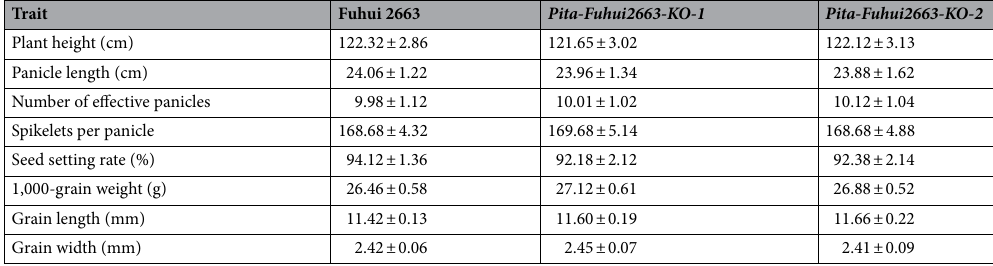
Table 2. Comparison of the main agronomical traits of Fuhui 2663 and the Pita-Fuhui2663 knockout